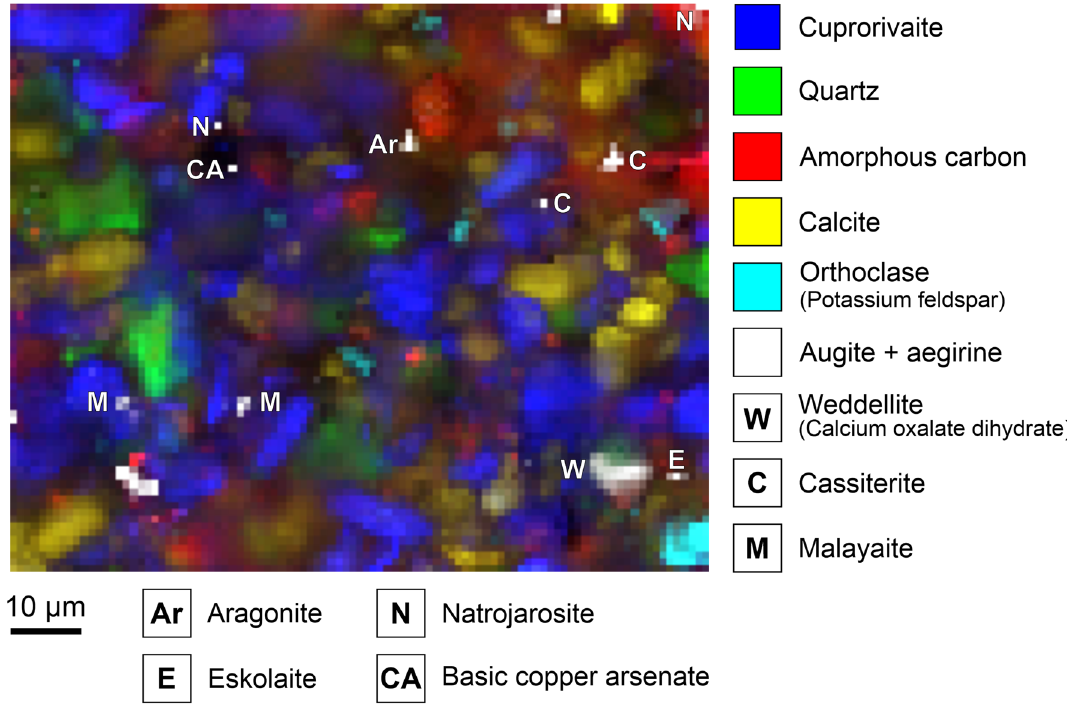
Figure 4. Raman map of the Egyptian blue paint layer. The intensities of marker bands reveal the distributions of eight trace constituents beyond the main components cuprorivaite, amorphous carbon (carbon black in the underpainting), quartz, calcite, and the feldspar